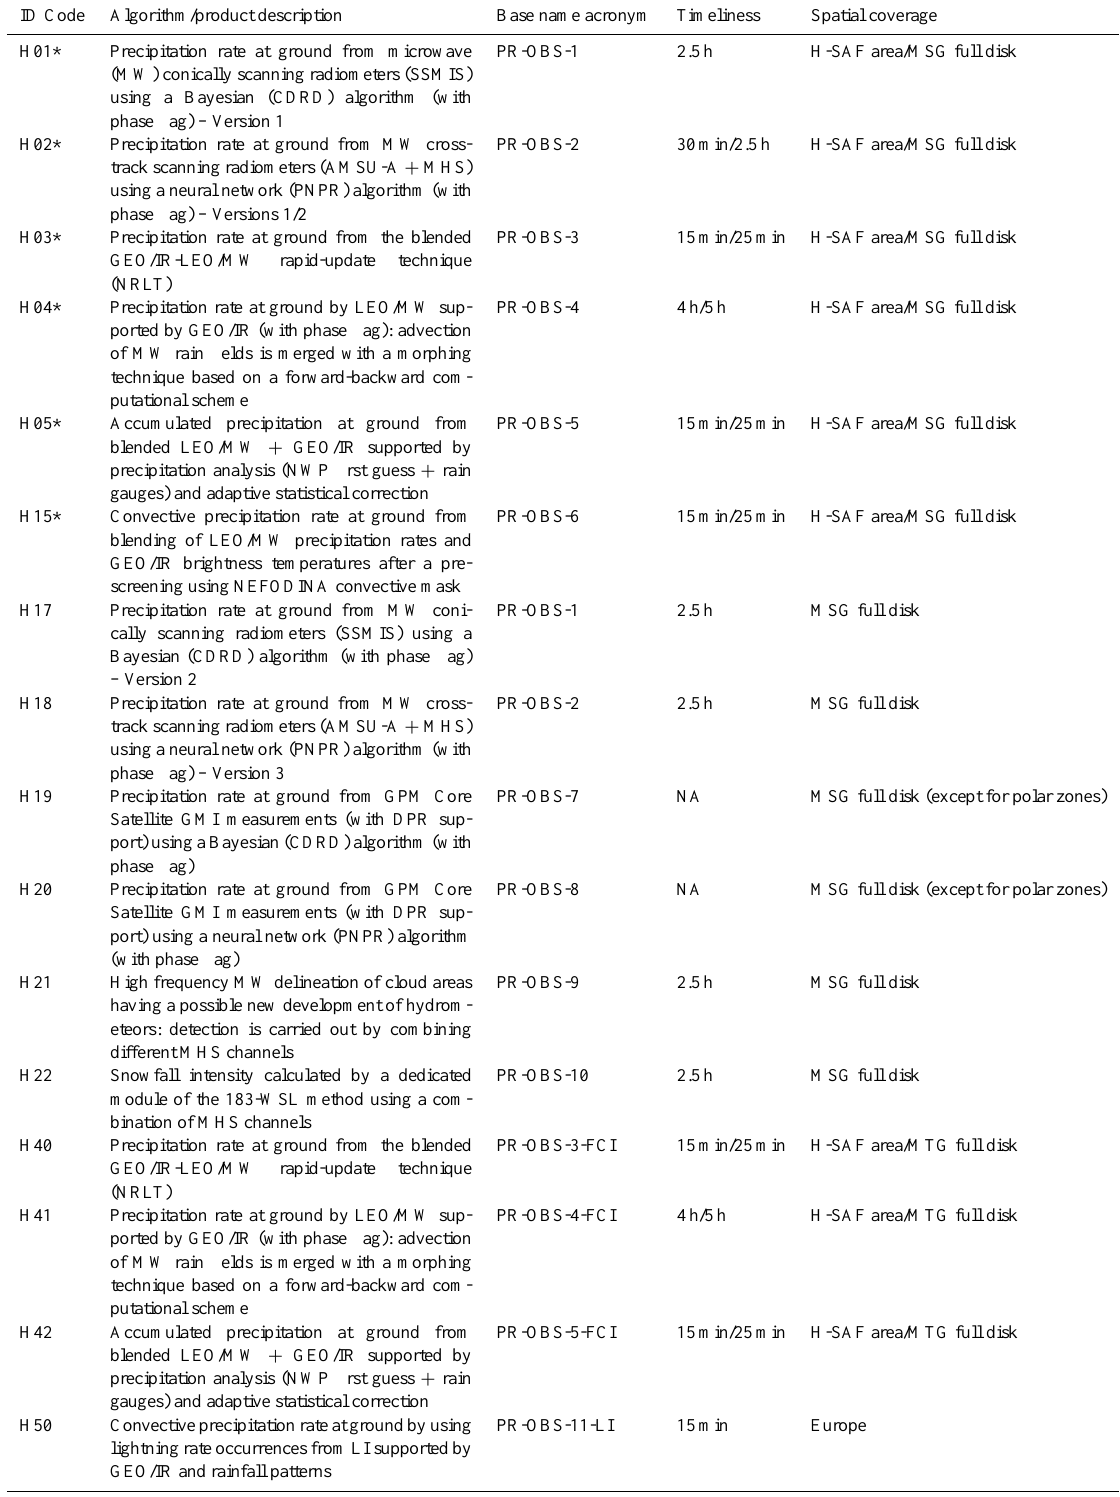
Table 3. H-SAF precipitation algorithms/products developed for or under development for CDOP-1 and CDOP-2 (see text for details). (Products developed during DP and CDOP-1 phases for H-SAF area are indicated with